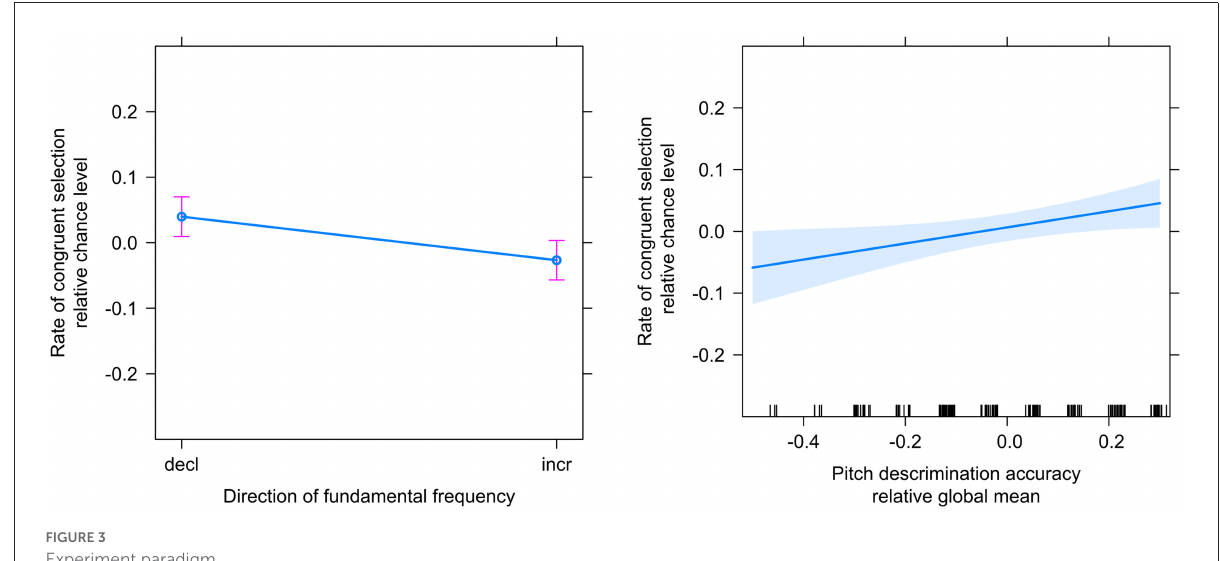
FIGURE3 Experiment